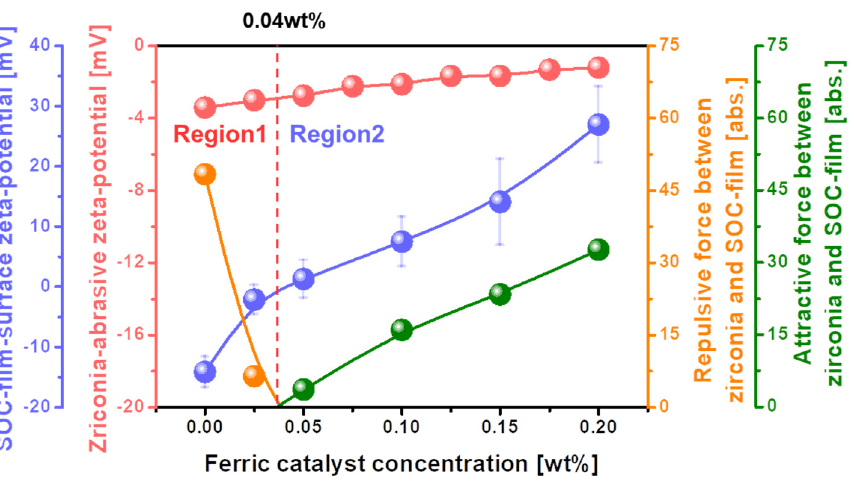
Figure 4. Relative electrostatic force between the ZrO 2 abrasives and the polished SOC film surface, depending on the ferric catalyst (Fe 2 (SO 4 ) 3 H 2 O)) concentration in the SOC film CMP slurry.